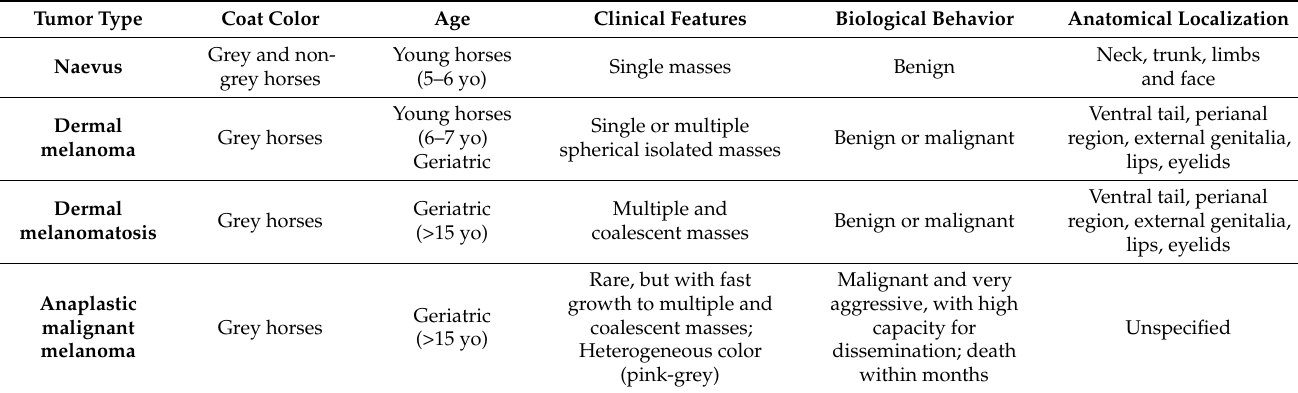
Table 2. General features of equine melanocytic tumor